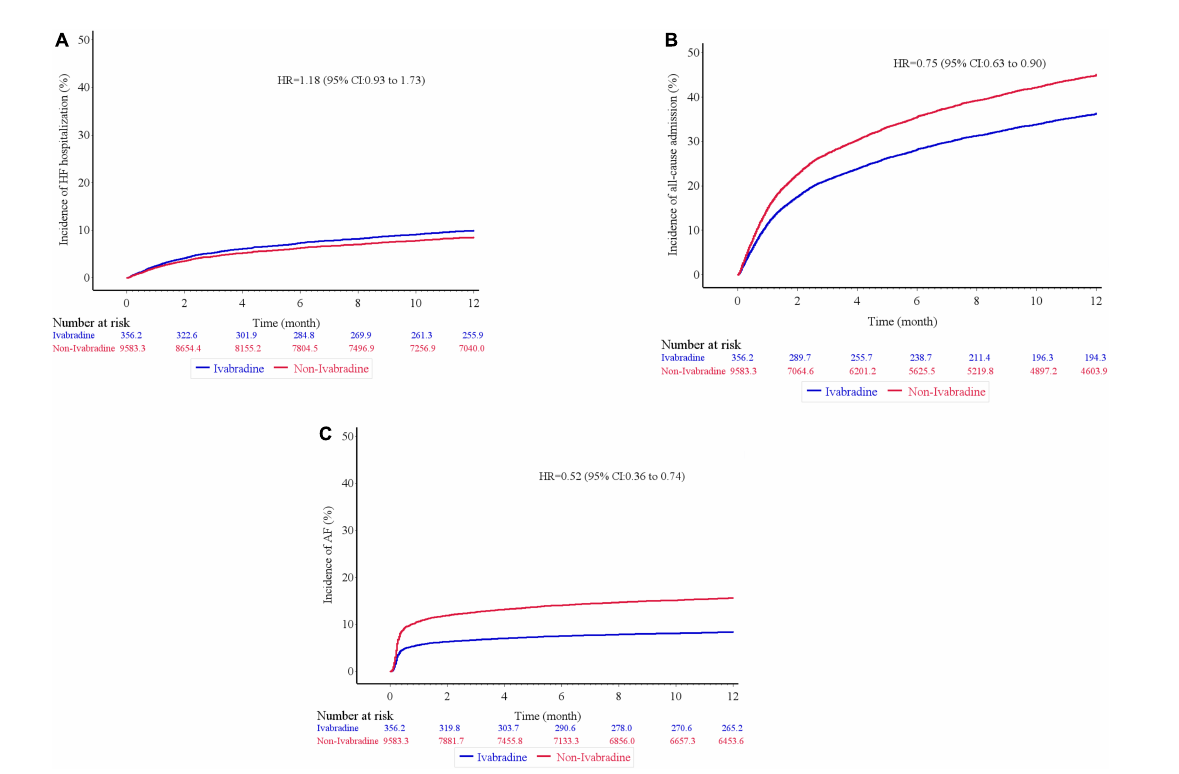
FIGURE3 Kaplan–Meier cumulative event curves of clinical outcomes. There was no significant difference in terms of heart failure hospitalization (A) , but the ivabradine group had lower incidence rates of all-cause hospitalization (B) , and newly developed atrial fibrillation (C) compared to the non-ivabradine group after inverse probability of treatment weighting analysis without further adjustments.